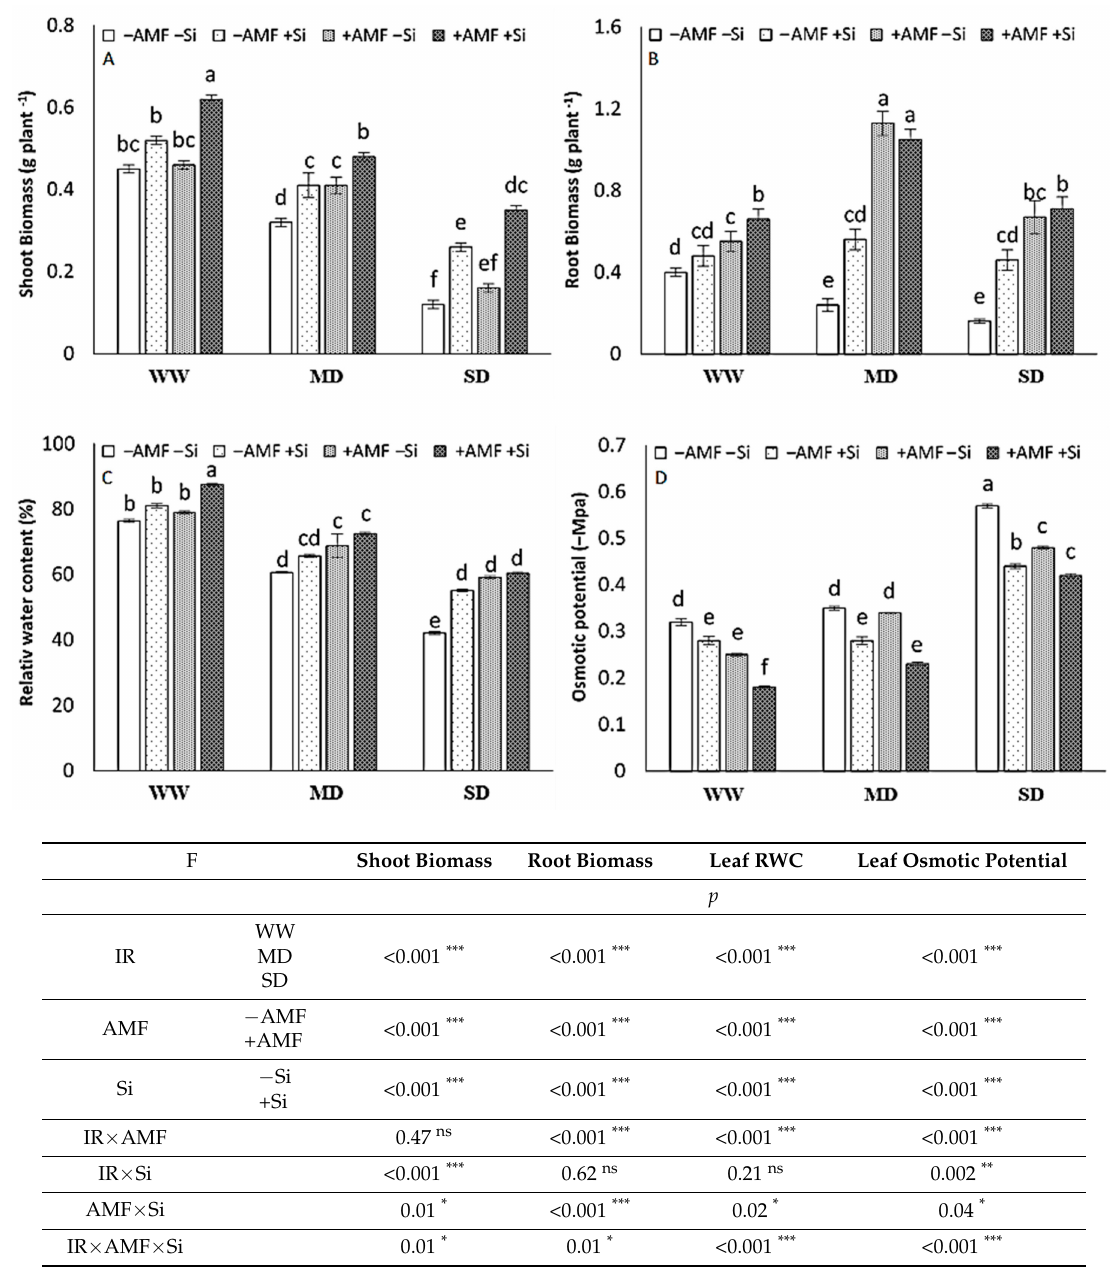
Figure 1. The biomass of shoot ( A ) and root ( B ), the leaf relative water content (RWC) ( C ), and the osmotic potential ( D ) in strawberry plants at harvest after six experimental weeks under three irrigation regimes (IR): well-watered (WW), mild drought (MD), and severe drought (SD) without ( − AMF) or with inoculation with arbuscular mycorrhizal fungus (+AMF) Rhizophagus clarus (Walker & Schüßler), in the absence ( − Si) or presence of silicon (+Si, 3 mmol L − 1 Na 2 SiO 3 ). The bars show the treatment means (4 replicates) ± SE of the mean. The interactions among the main factors are in the table ( F ); *** p < 0.001, ** p < 0.01, * p < 0.05, and ns is not significant (Tukey test, alpha =